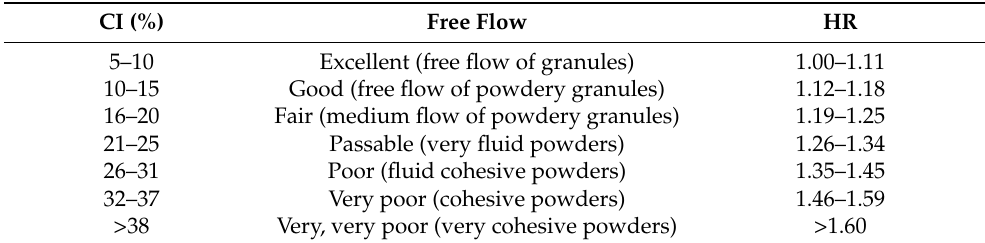
Table 2. Powders flowability